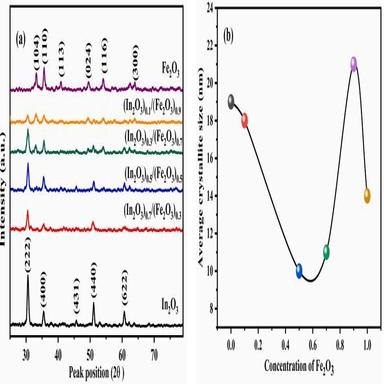
(a) XDR pattern of (In2O3)x/(Fe2O3)1-x (where x = 1, 0.9, 0.5, 0.3, 0.1, 0) (b) Average crystallite size (nm) versus Fe2O3 (%) contents in In2O3/Fe2O3 nanocomposites.